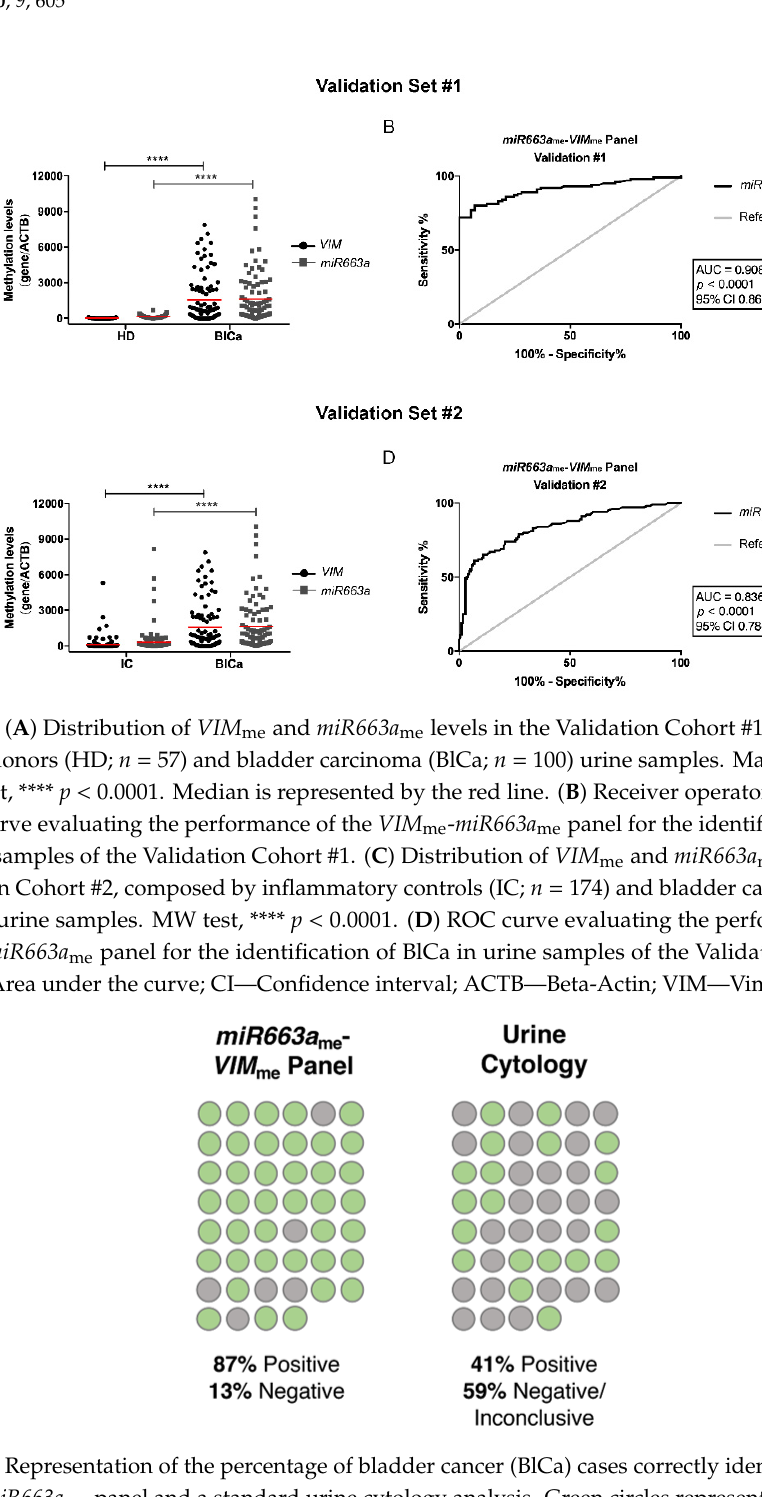
Figure 4. Representation of the percentage of bladder cancer (BlCa) cases correctly identified with the VIM me - miR663a me panel and a standard urine cytology analysis. Green circles represent positive cases, grey circles represent negative/inconclusive cases.